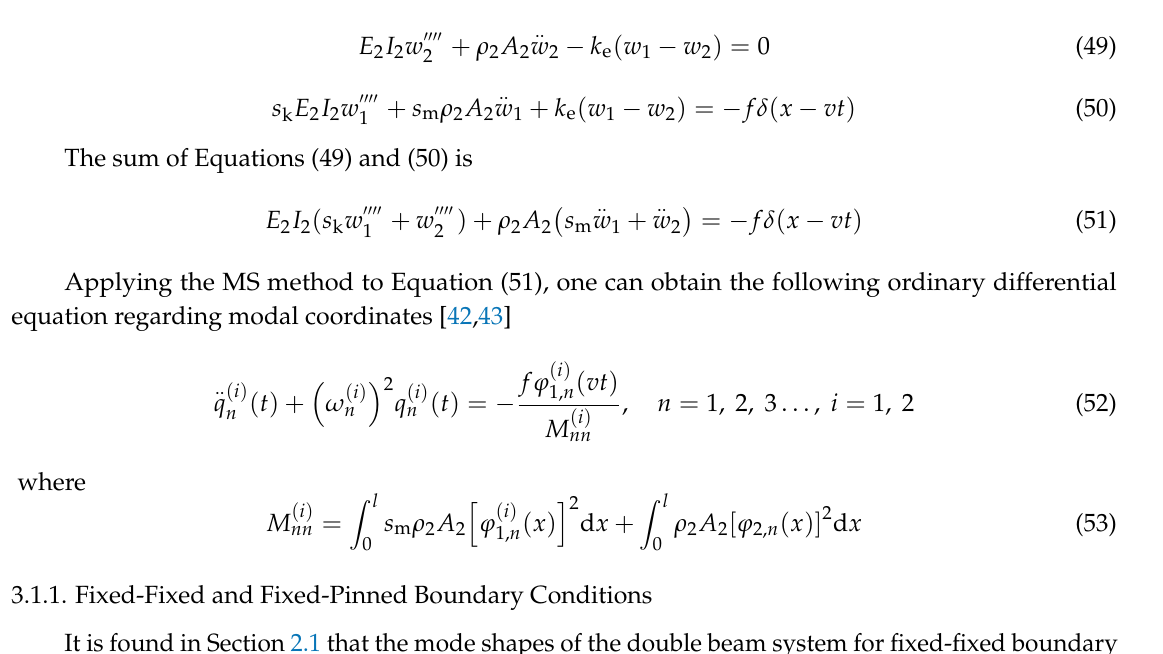
Figure 11. Double-beam system with symmetric boundary conditions traversed by a moving force.